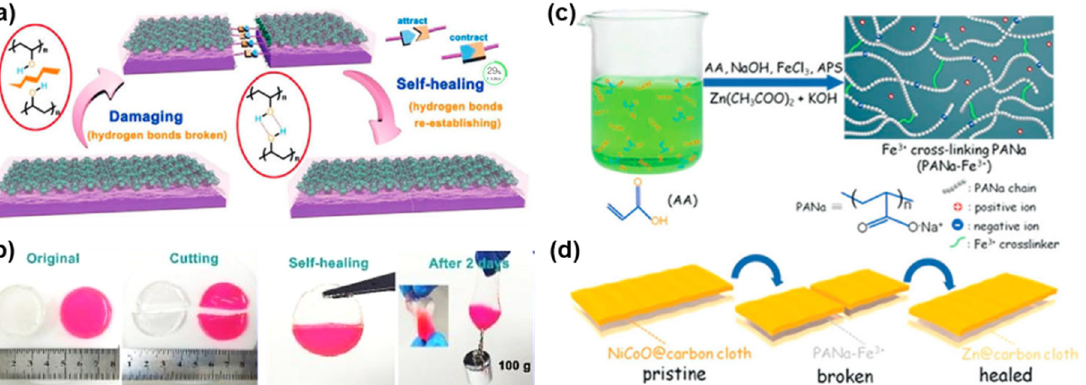
Figure 5. ( a ) Working mechanism of the self-healing PVA/Zn(CF 3 SO 3 ) 2 hydrogel electrolyte. ( b ) The self-healing behaviors of the self-healable hydrogel electrolyte. Reproduced with permission from [35]. ( c ) Fabrication of the self-healable ionic-crosslinked hydrogel electrolyte. ( d ) Schematic illustration of the self-healing ZIBs. Reproduced with permission from [53].